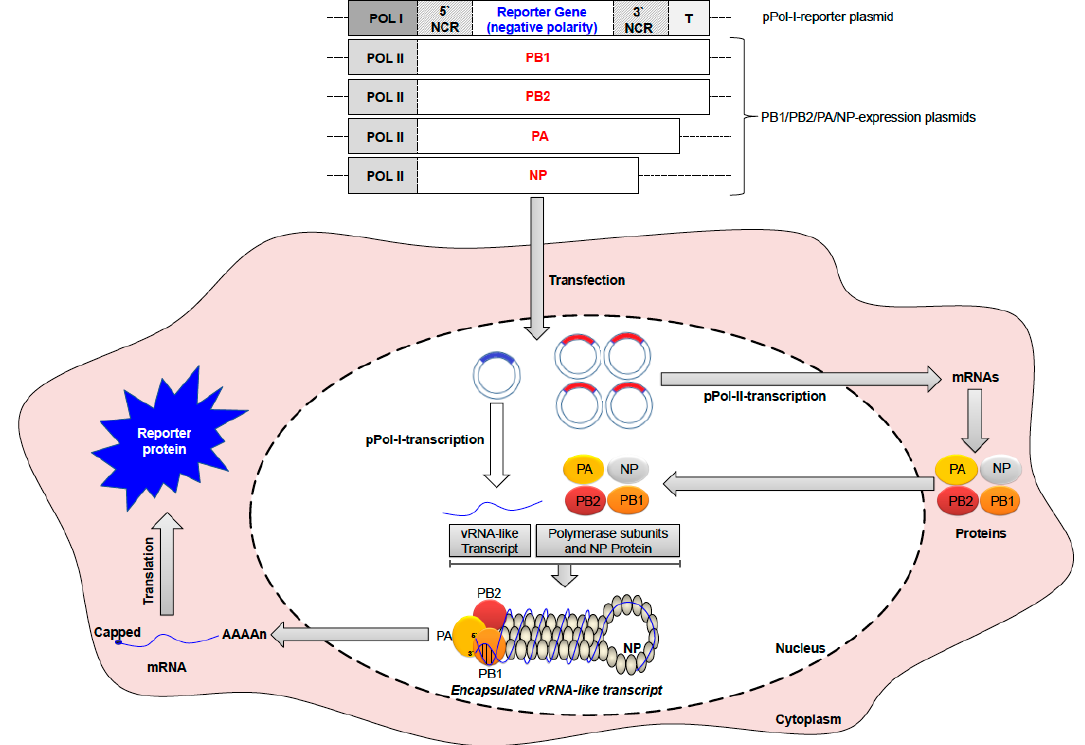
Figure 2. Overview of minigenome assay for IAV. The DNA of four expression plasmids, encoding the PB1, PB2, PA, and NP of IAV under control of polymerase II promoter (Pol-II), are co-transfected into host cell with reporter plasmid, which is carrying the ORF of the reporter gene (e.g., Luciferase, CAT, GFP) in a negative polarity and flanked by the NCRs of an IAV segment. Transcription is controlled by a Pol-I promoter (Pol-I) and a Pol-I terminator (T) to express a specific vRNA-like Pol- I-transcript of the reporter gene. The expression of the viral proteins together with the vRNA-like reporter gene transcript results in the in vitro reconstitution of RNP complexes. The RNP complexes generate the corresponding mRNA, which is then translated into the reporter protein of unique enzymatic, fluorescent or chemiluminescence activity. The represented regions in plasmid constructs are not drawn to